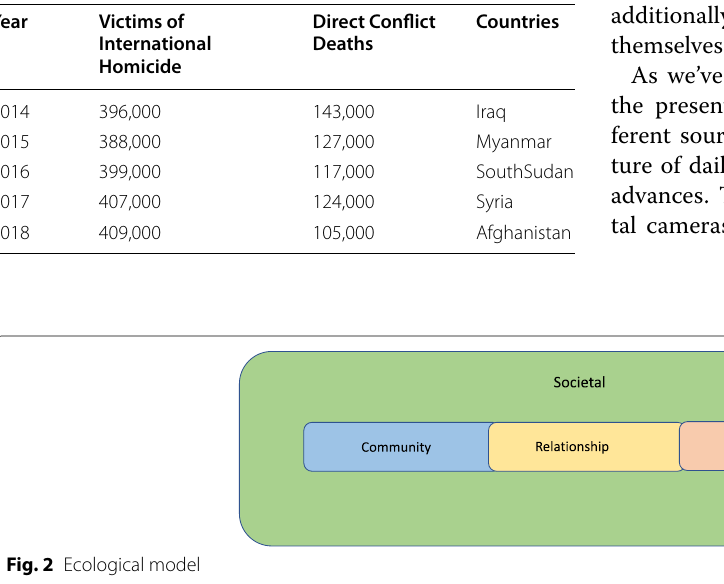
Table 1 Number of intentional homicides and direct conflict deaths